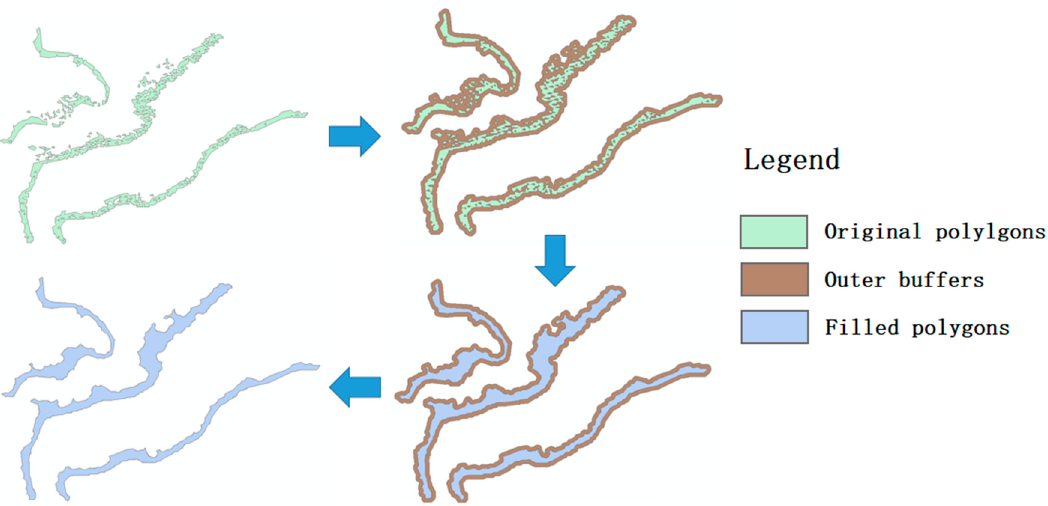
Figure 7. Filling holes in trail polygons.